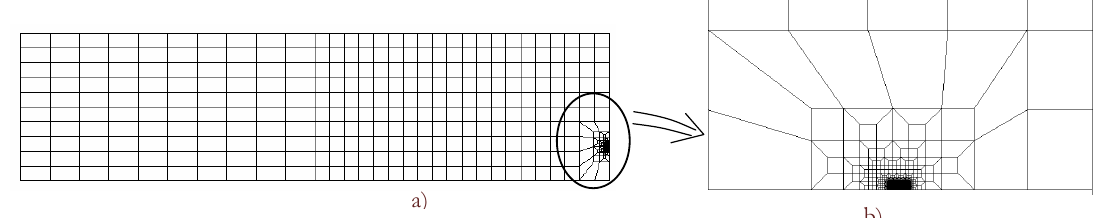
Figure 1: Finite element mesh. a) Frontal view. b) Detail of frontal